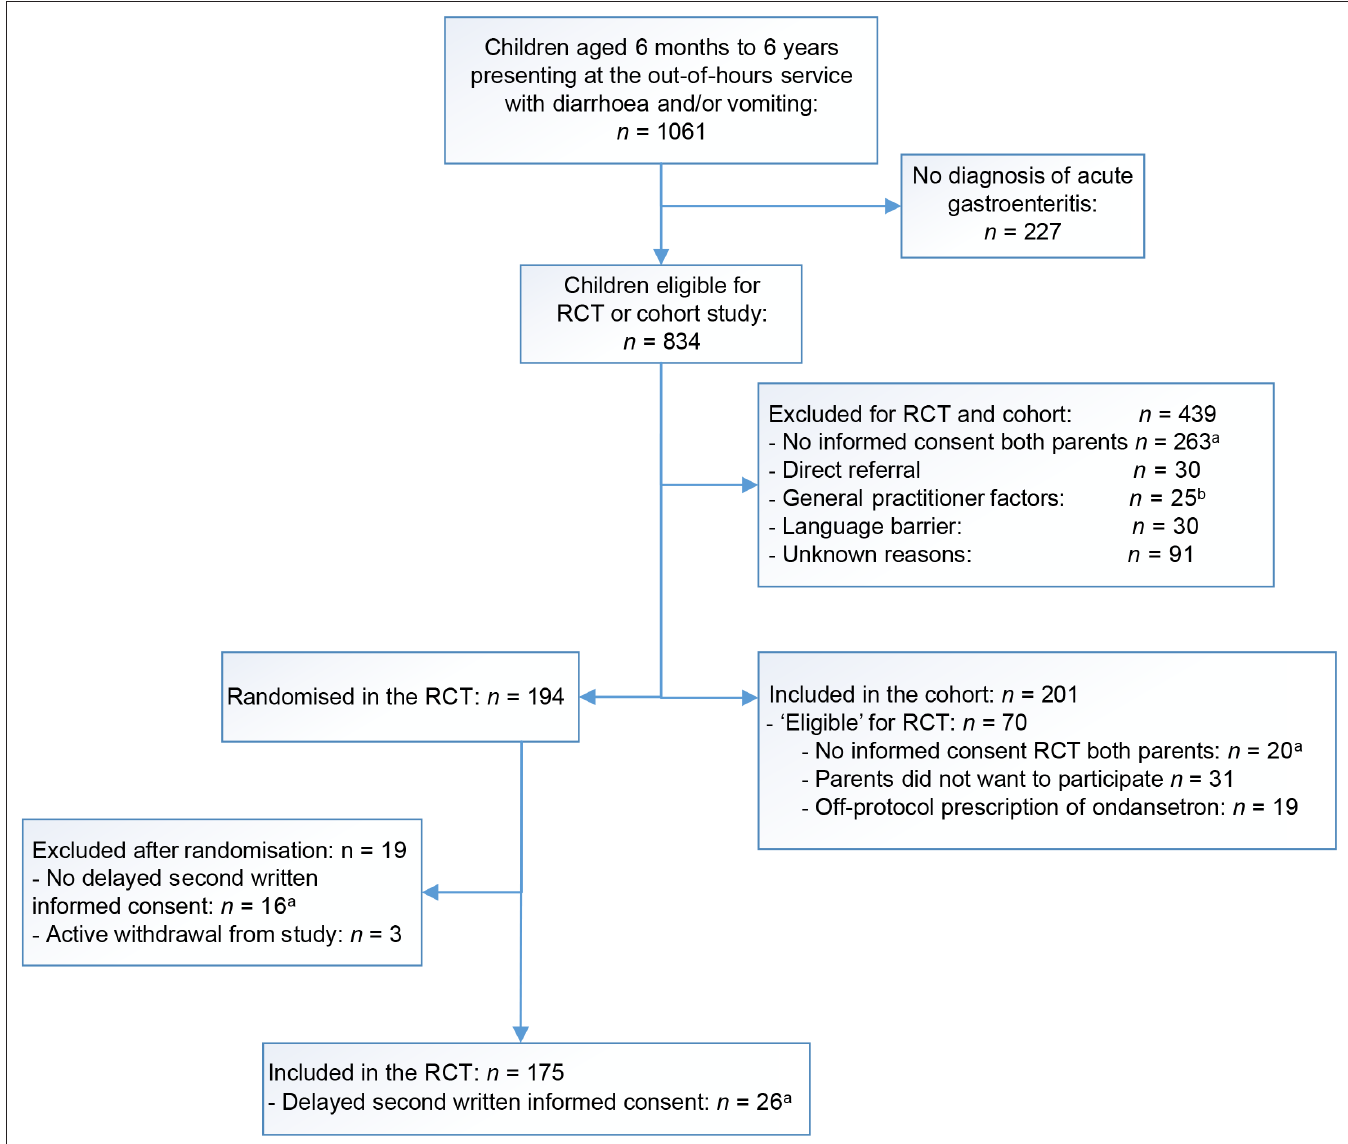
Figure 2 Study flow diagram. RCT = randomised controlled trial. a Only one parent was present ( n = 325). b GP objected to ondansetron use ( n = 16) or did not agree with inclusion ( n =